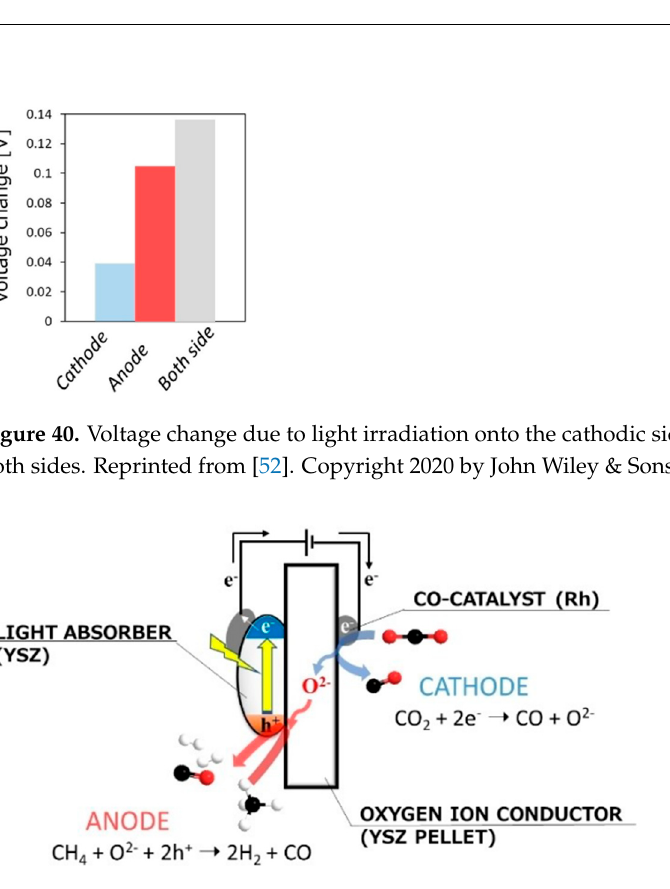
into the anodic side and CO 2 into the cathodic side. The reaction temperature was 600 °C and UV